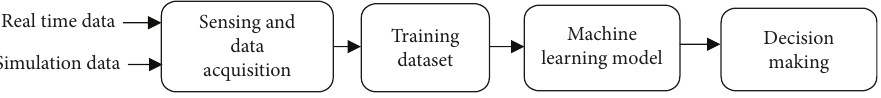
Figure 12: Overview of MLT detection